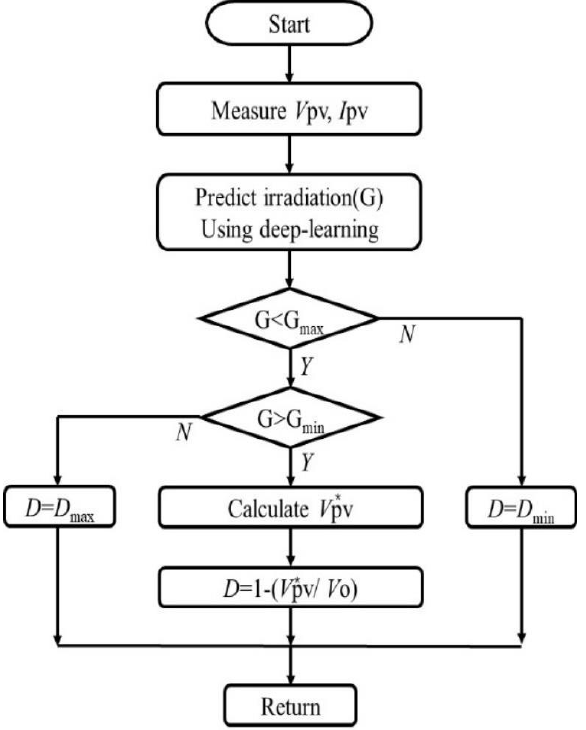
Figure 6. Block diagram of the proposed control algorithm for solar power generation.